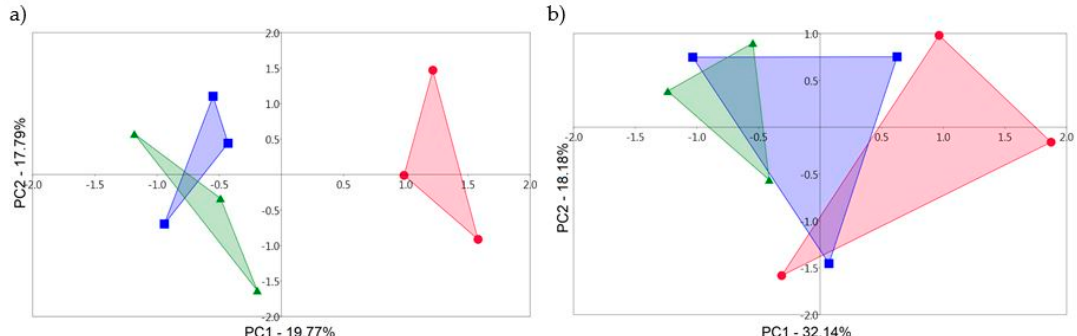
Figure 2. The principal component analysis (PCA) constructed from T-RFLP fluorescent data of fungal communities from Arundo donax rhizosphere collected in ( a ) 2014 and ( b ) 2015 in control samples and samples with sewage sludge (SS) in doses of 5 and 15 t / ha. PCA graphs explained a total of 37.56% and 50.32% (respectively) of the variability in the data. PCA was made by combining data from two sampling dates in each year into a single statistical table. Red—control sample; blue—sample with 5 t / ha of SS; green—sample with 15 t / ha of SS.